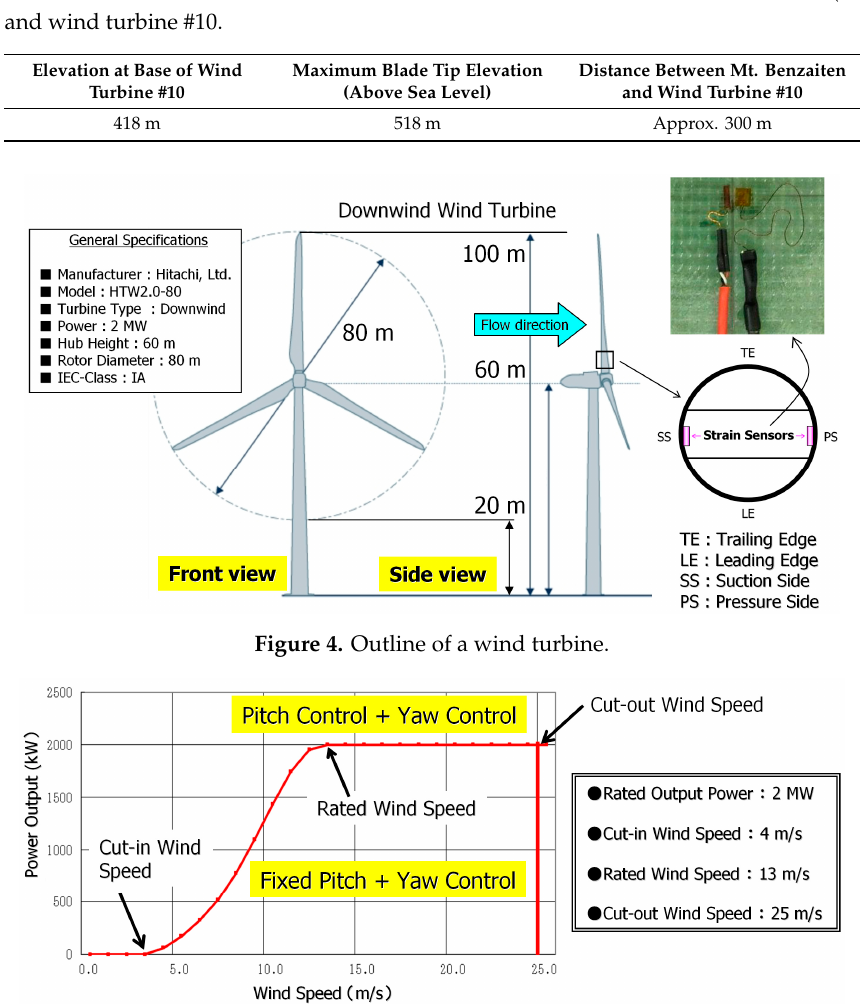
Figure 5. Power curve of a wind turbine.